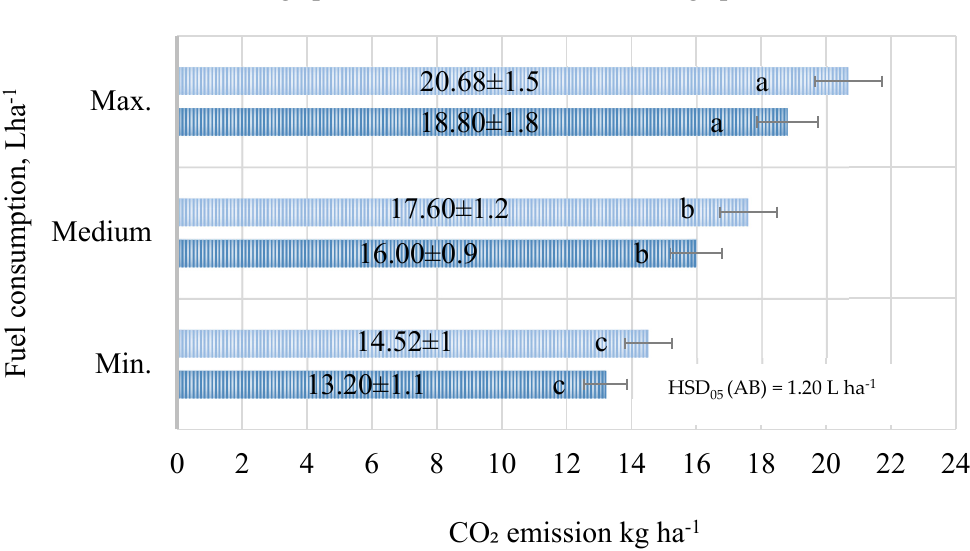
Figure 9. Impact of shredding roller on CO 2 emissions. Columns marked with the same letter mean the results have significant differences (probability level P<0.05).